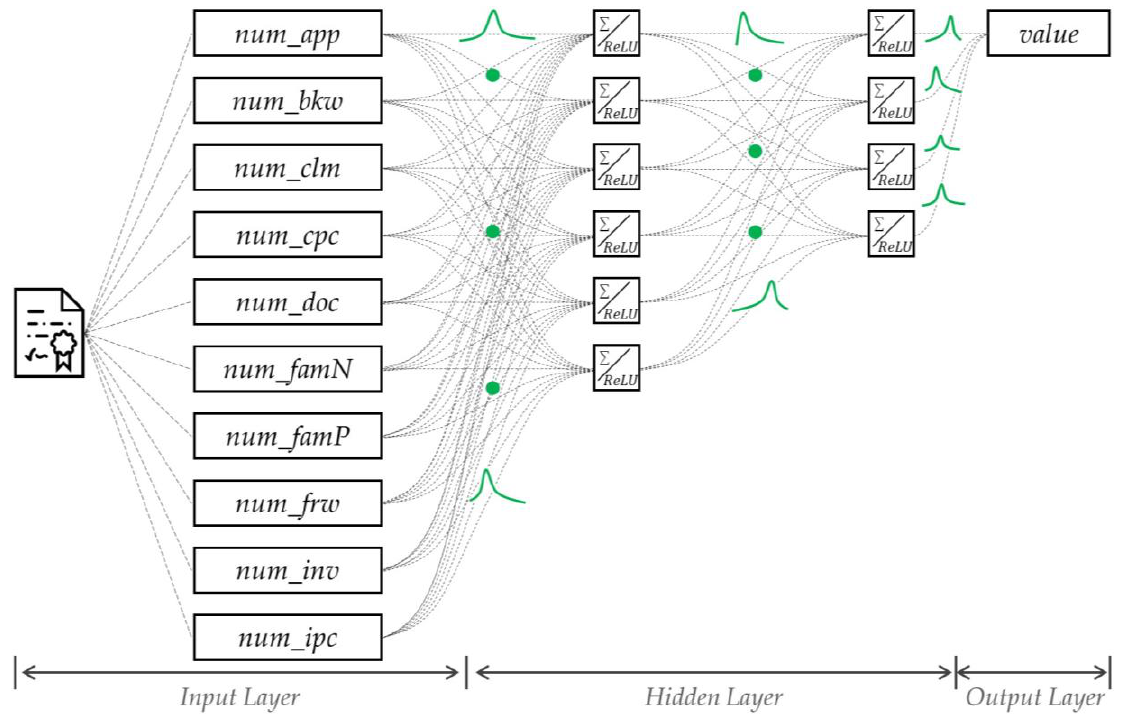
Figure A1. Architecture of the Bayesian neural network used in the experiment. The BNN used in the experiment uses the evaluation factor extracted from the patent document as an input variable. Next, the input layer containing the factors passes the value of the patent to the output layer via the hidden layer. The weight of each layer is determined by the statistical distribution.